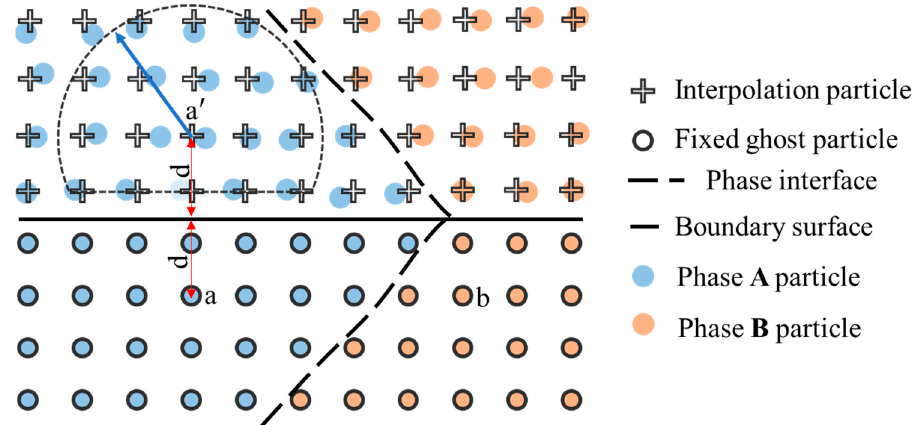
Figure 3. Boundary